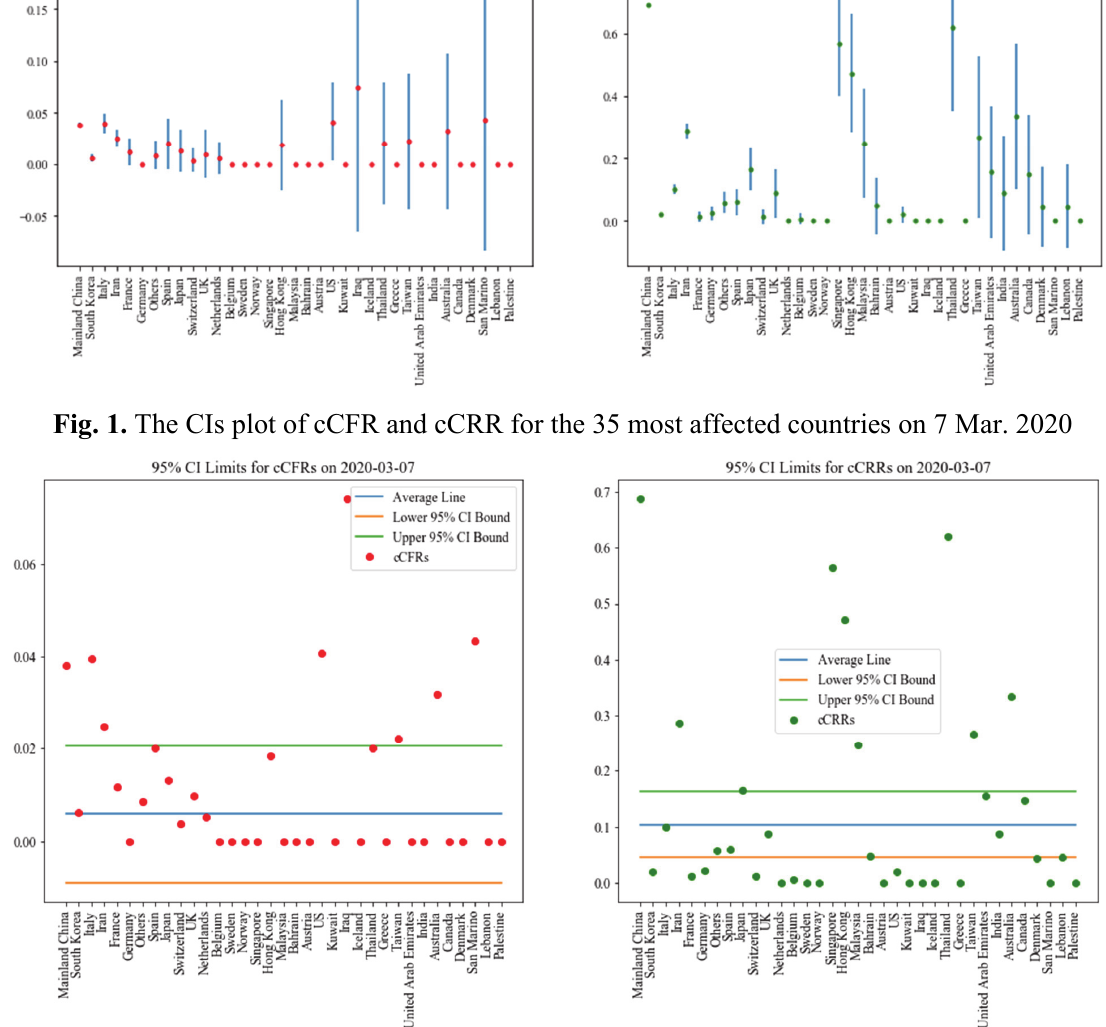
Fig. 2. The cCFR and cCRR for the 35 most affected countries on 7 Mar. 2020 along with the 95% CI for the overall cCFR and